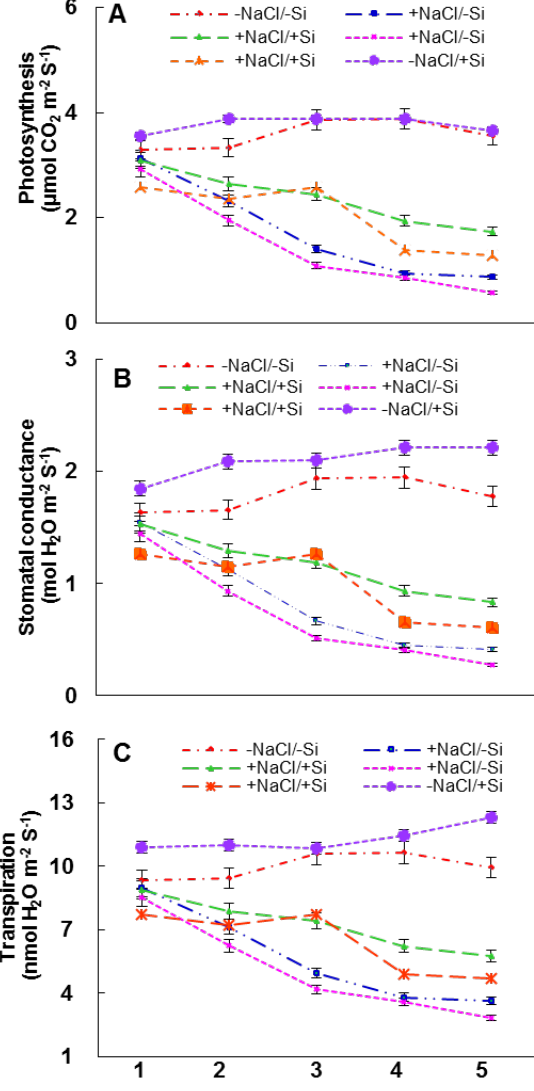
Figure 6. Changes in photosynthetic parameters ( A ) photosynthesis rate ( B ) stomatal conductance and ( C ) transpiration in leaves of tomato ( Solanum lycopersicum L.) as affected by NaCl/Si combined treatments along with Control [−NaCl/−Si]: −Si with NaCl [25 mM, +NaCl/−Si], +Si with NaCl [25 mM, +NaCl/+Si], −Si with NaCl [50 mM, +NaCl/−Si], +Si with NaCl [50 mM, +NaCl/+Si] and with additional control +Si without NaCl [−NaCl/+Si]. Vertical bars indicate ± S.E. of the means for n = 5. Means denoted by the different letter are significantly different at p < 0.05 according to the Tukey’s studentized range